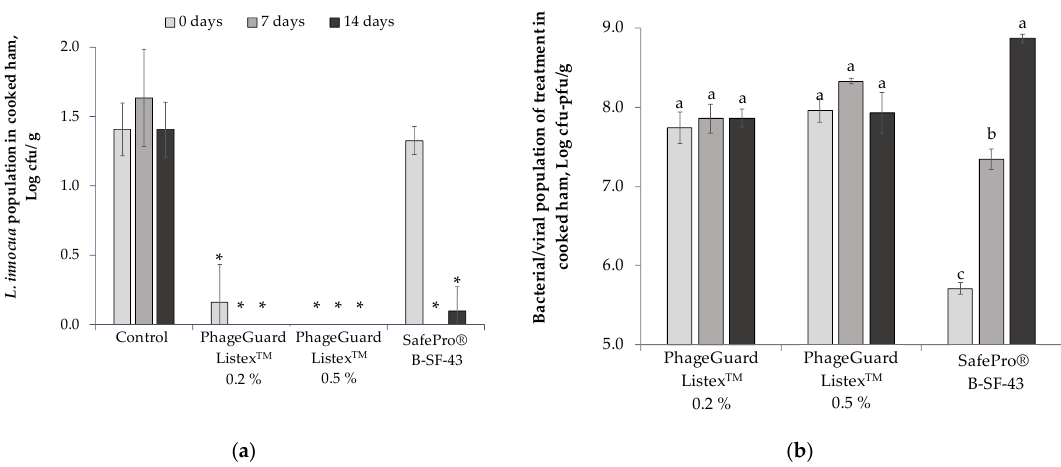
Figure 2. Effect of the biopreservative treatments on sliced cooked ham under semi-commercial conditions (4 °C plus modified atmosphere packaging): ( a ) L. innocua population on sliced cooked ham throughout storage. Values are means ± standard deviations of three biological replicates. Bars marked with an asterisk represent statistically significant differences between the treatment and the control ( p < 0.05) at each sampling time. ( b ) Counts of Leuconostoc carnosus (formulated in SafePro ® B-SF-43 treatment) and bacteriophage P100 (0.2 and 0.5% PhageGuard Listex TM treatments) on sliced cooked ham throughout storage. Values are means ± standard deviations of three biological repli- cates. Bars marked with different letters (a, b and c) represent statistically significant differences among sampling time ( p < 0.05) at each evaluated treatment. Table 1. The O 2 and CO 2 concentration in the trays of sliced cooked ham treated with biopreserva- tion techniques and stored at 4 °C under modified atmosphere packaging. Values are means ± stand- ard deviations of three trays.